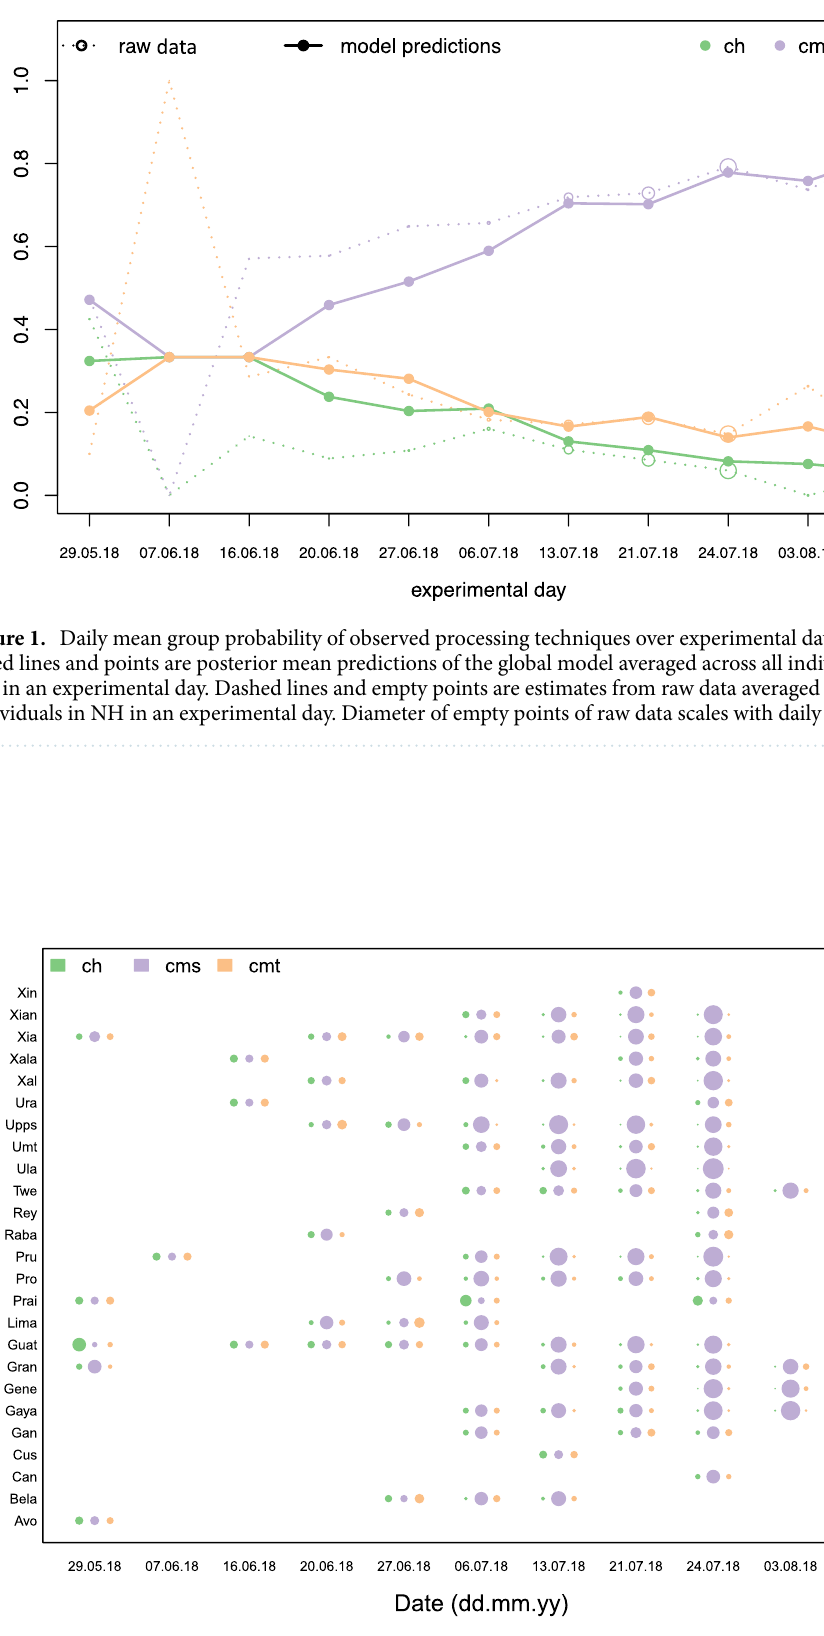
Figure 2. Visualization of posterior estimates from the global model of daily mean probability of processing techniques across all foraging individuals in NH. Point diameter scales with probability, with many individuals approaching fixity of CMS on the final